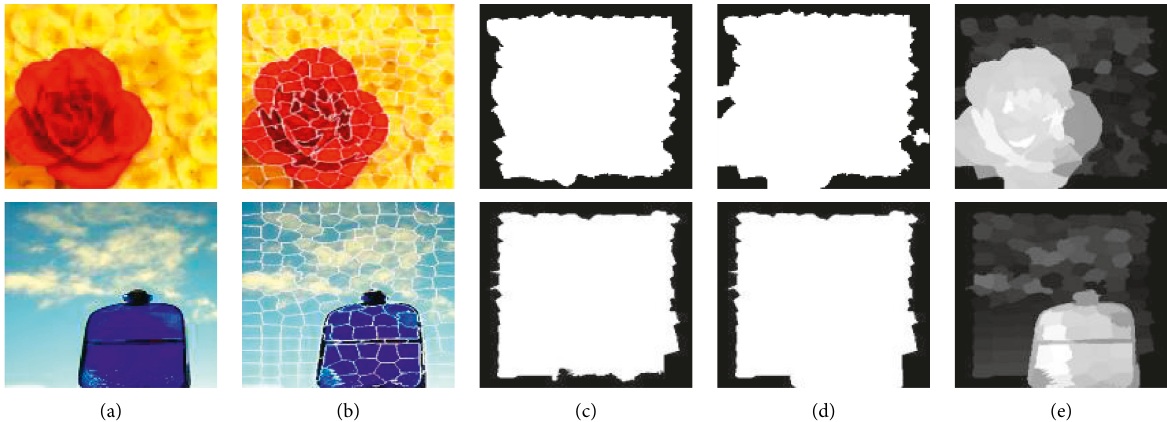
Figure 2: Color contrast-based saliency detection. (a) Original image; (b) superpixel segmentation; (c) candidate background template; (d) final background template; and (e) color contrast-based saliency map.